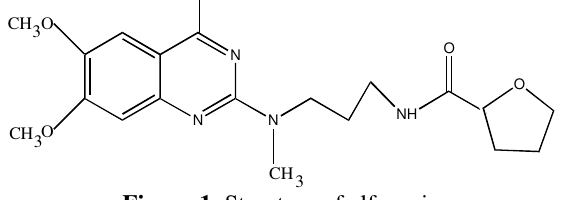
Figure 1. Structure of